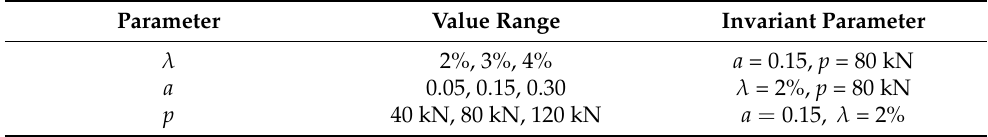
Table 4. Working Condition